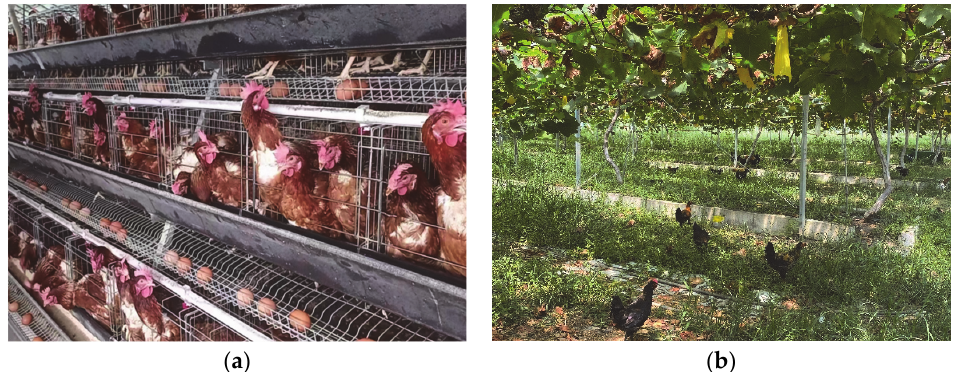
Figure 1. Production of laying hens and eggs in China. ( a ) Intensive cage system for laying hens. ( b ) Raising laying hens in the forest. Note: ( a ) provided by Shaocong Yan; ( b ) provided by Lei Zhu.